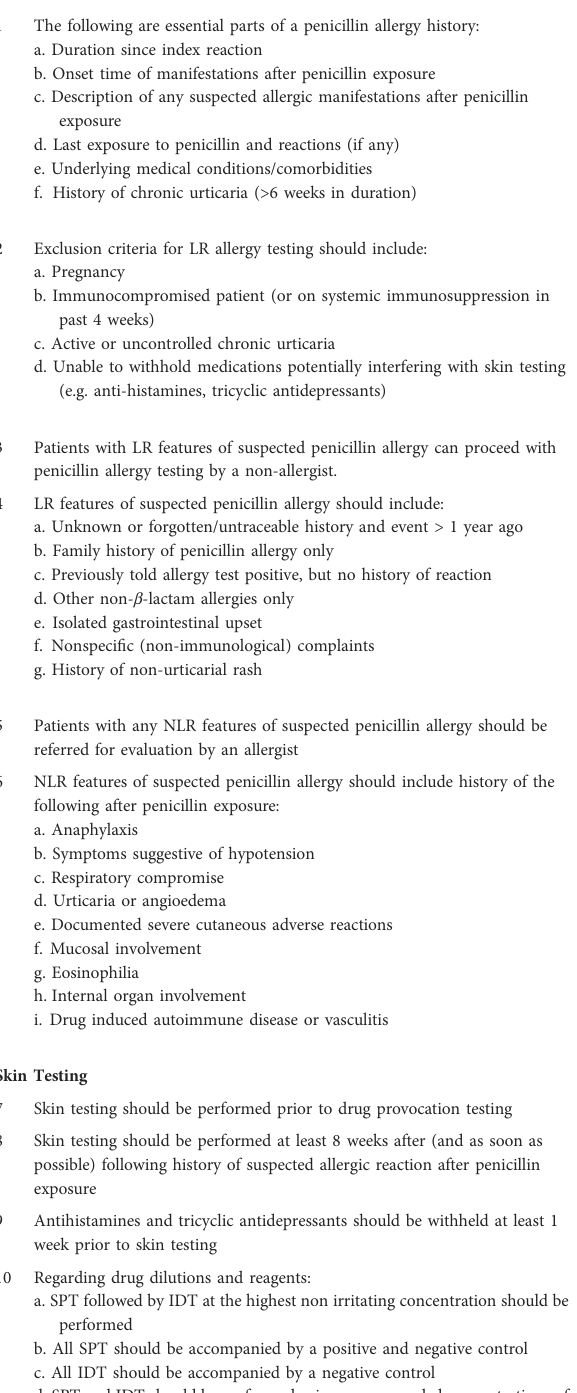
CS #8: Skin testing should be performed at least 8 weeks after (and as soon as possible) following history of suspected allergic reaction after penicillin exposure (score: 0.88 ± 0.23) . Agreement: 100%.